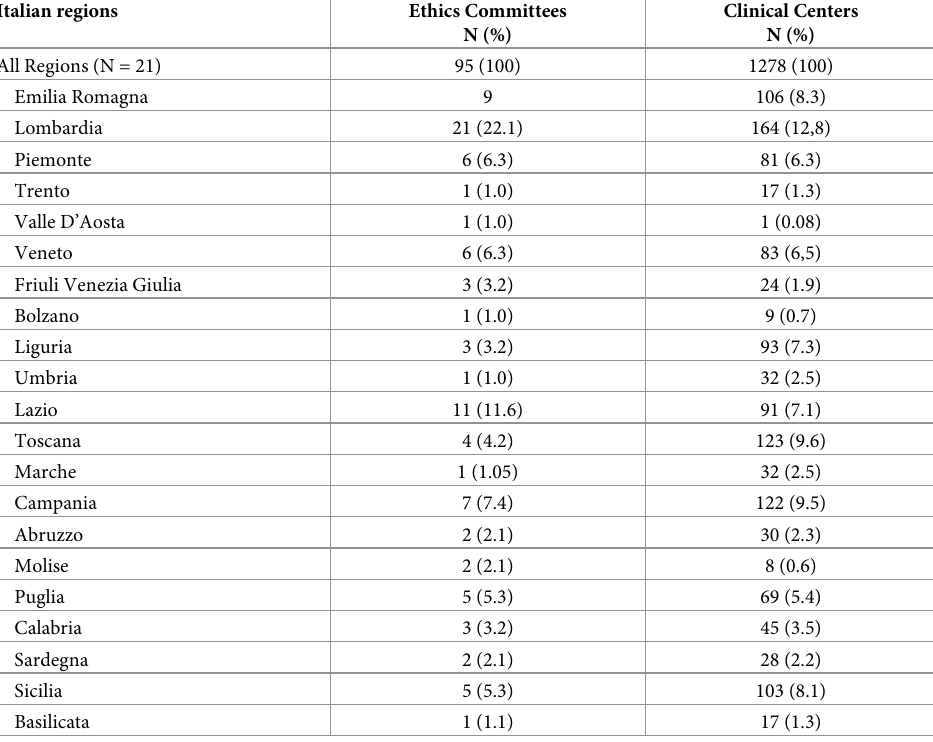
Table 2. Ethics committees and clinical centers by geographical regions (December